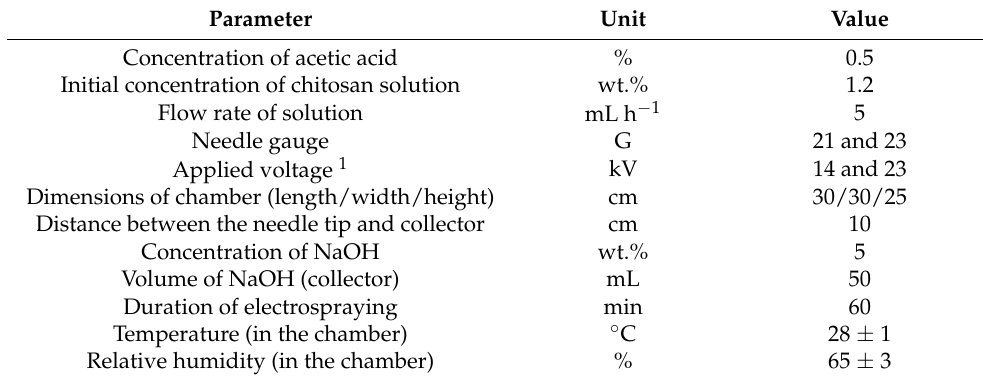
Table 1. Experimental conditions for